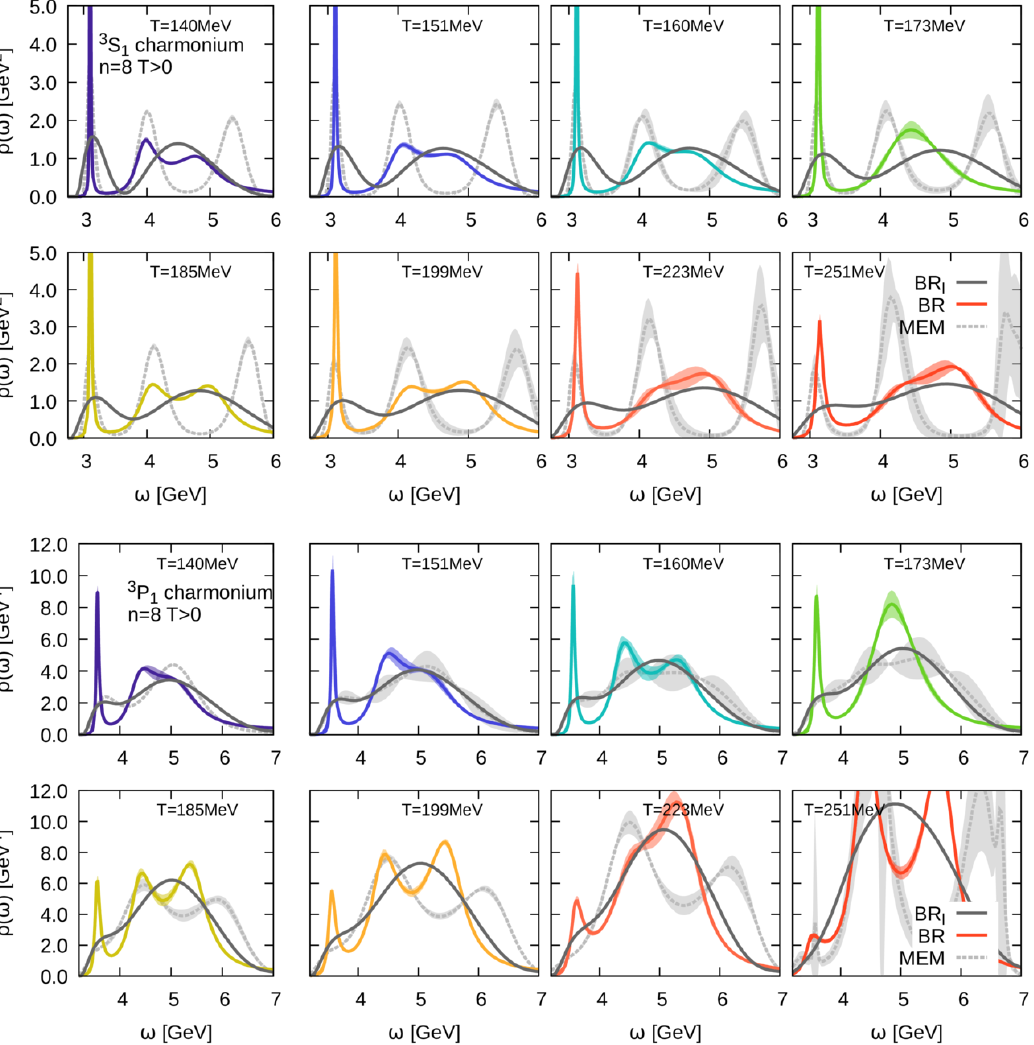
Figure 22 . Finite temperature spectral functions for charmonium obtained from the standard BR method (colored solid) the MEM (gray dashed) and the smooth BR method (dark gray solid) The top two rows contain the results for the 3 S 1 channel, each panel showcasing a di(cid:11)erent temperature. The lower two rows on the other hand contain the 3 P 1